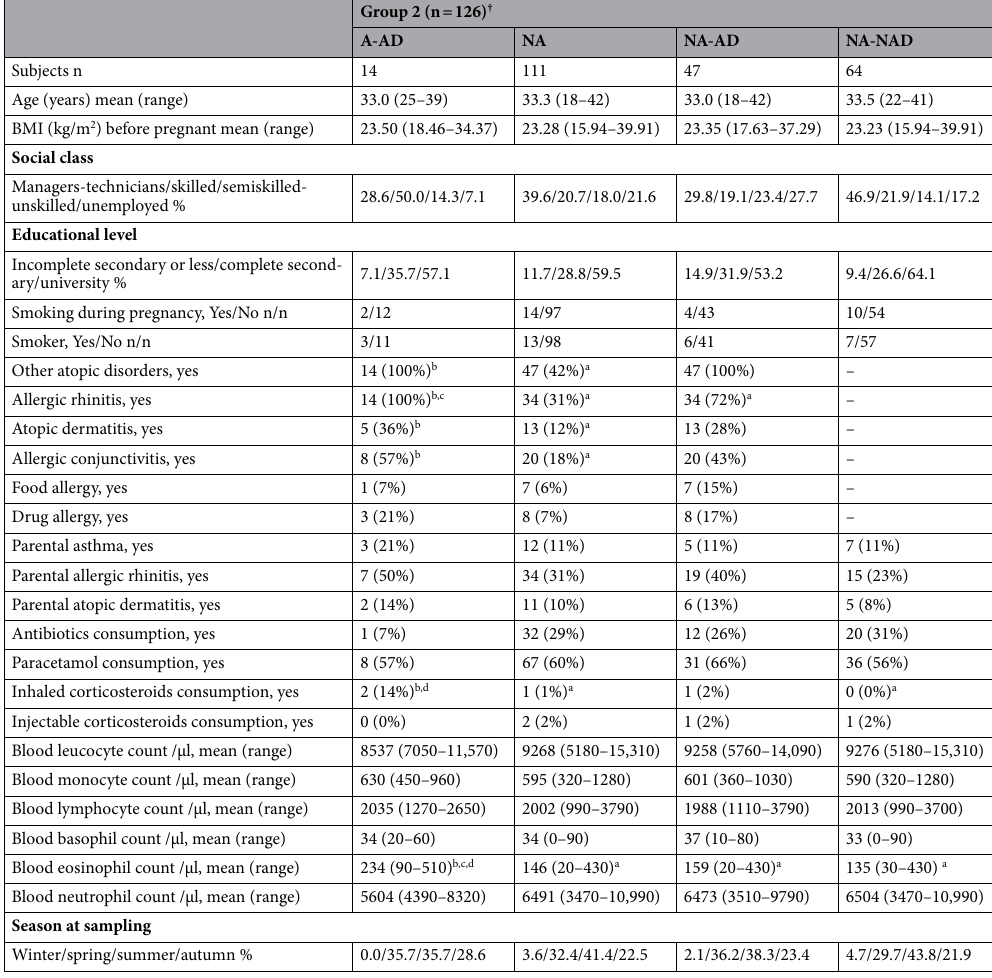
Table 2. Characteristics of the study population: women of childbearing age (Validation set—Group 2). A‑ AD asthmatics with other coexisting atopic diseases; NA non-asthmatics; NA‑NAD non-asthmatics without atopic diseases; NA‑AD non-asthmatics with other atopic diseases. a Significantly different (p-value < 0.05) from asthmatics with coexisting other atopic diseases (A-AD). b Significantly different (p-value < 0.05) from non-asthmatics (NA). c Significantly different (p-value < 0.05) from non-asthmatics with other atopic diseases (NA-AD). d Significantly different (p-value < 0.05) from non-asthmatic without atopic diseases (NA-NAD). † One woman was not included in any of the four categories for being asthmatic without other atopic